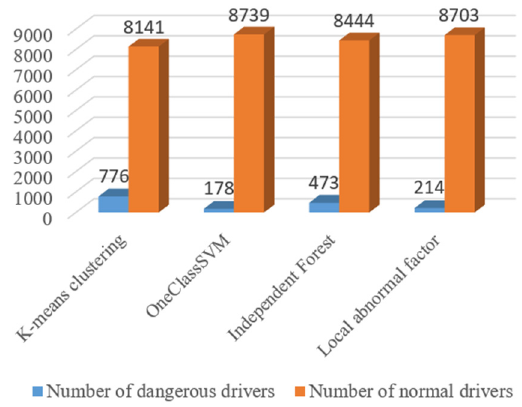
Figure 3. The ratio of Dangerous drivers.